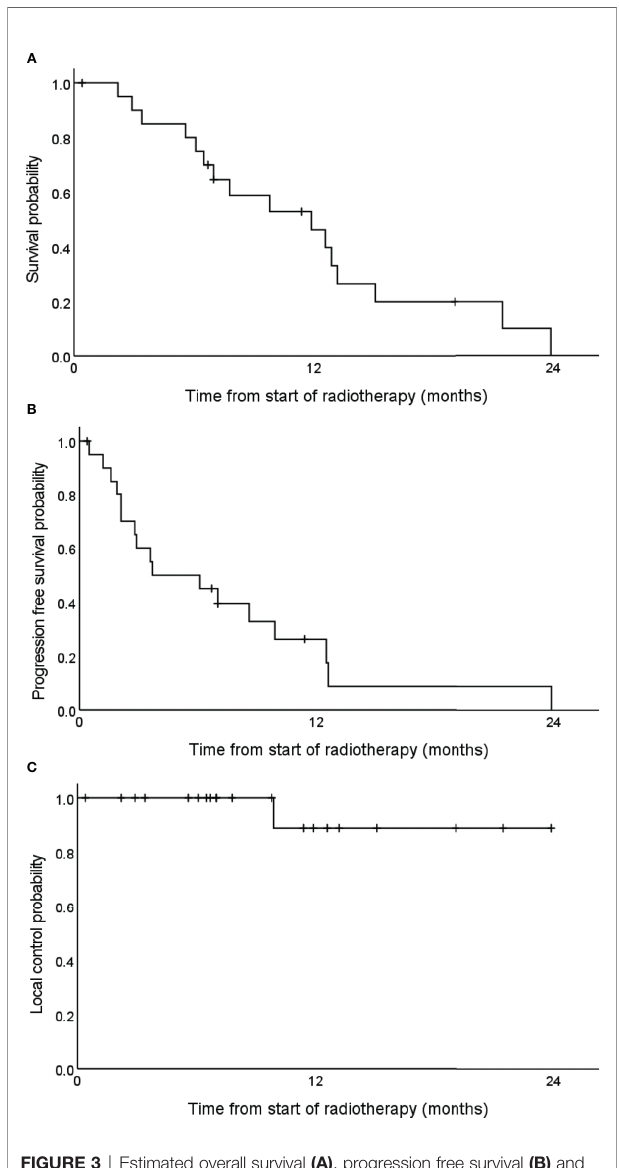
FIGURE 3 | Estimated overall survival (A) , progression free survival (B) and local tumor control (C) rates of 21 locally advanced pancreatic cancer patients after carbon ion radiotherapy with 48 Gy (RBE) in 12